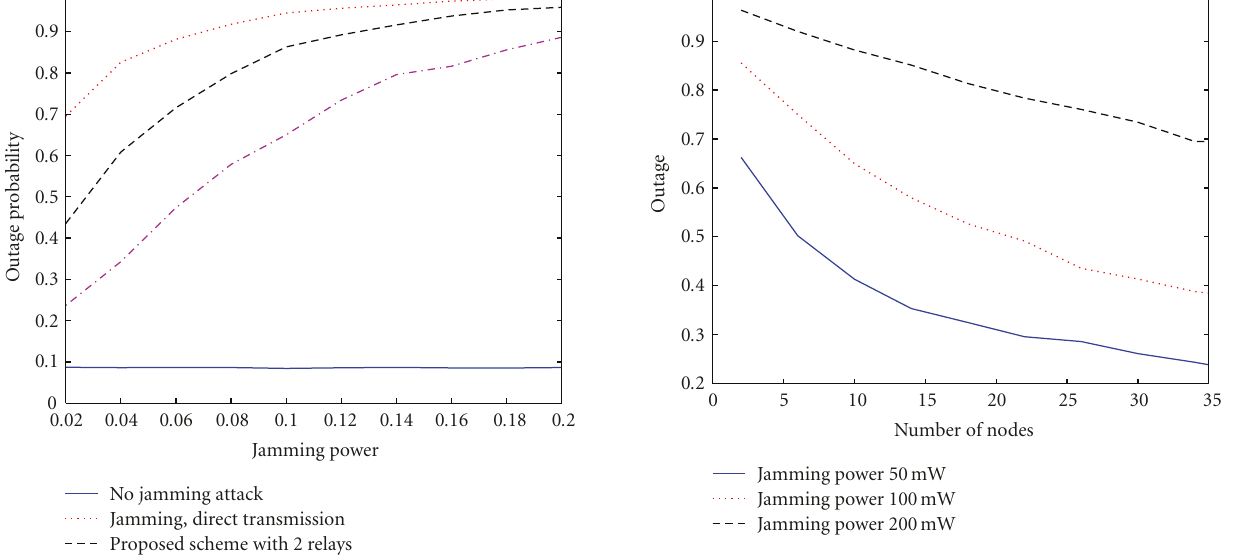
Figure 8: Outage probability versus the number of relays in the proposed scheme.